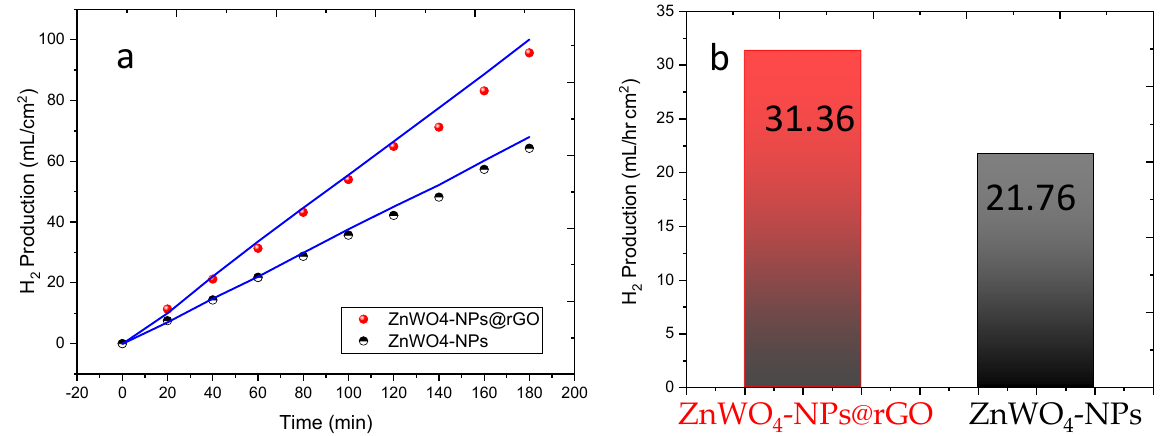
Figure 5. ( a , b ) Electro-catalytic H 2 production efficiency of ZnWO 4 -NPs@rGO nanocomposites and ZnWO 4 -NPs. ZnWO 4